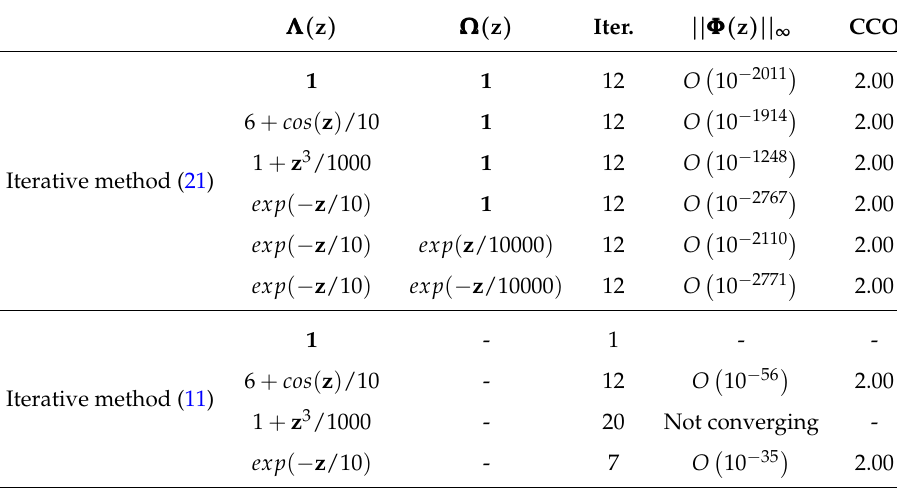
Table 3. Problem 3: initial guess = [ 2,4,3 ] , m = [ 1/2,1/2,1/2 ]